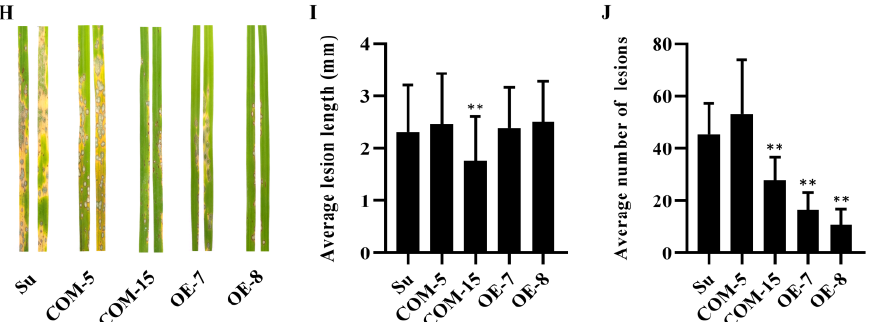
Figure 6. Pb2 can significantly reduce the number of diseased grains and leaf diseased spots. ( A ) Gene structure of Pb2 and two types of mutation. ( B , E ) Rice panicle three weeks after injection of Hoku1 spore suspension at booting stage, Nanjing, 2020. Jiang represents the CRISPR-Cas9 transgenic receptor plant and Su represents the complementary and overexpressing transgenic receptor plant. ( C , D , F , G ) Percentage diseased grains (%) of transgenic lines and WT was counted three weeks after inoculation, and each bar represents the average of nine panicles. ( H ) Response of three-week-old seedlings 6 days after inoculation with Hoku1 . ( I , J ) Average lesion length and average number of lesions in WT and transgenic plants. Lesion length and lesion number were measured 6 days after inoculation. Error bars represent standard deviation, and differences between WT and experimental groups were tested with GraphPad Prism 8.3 t -test, * p < 0.05, ** p < 0.01.